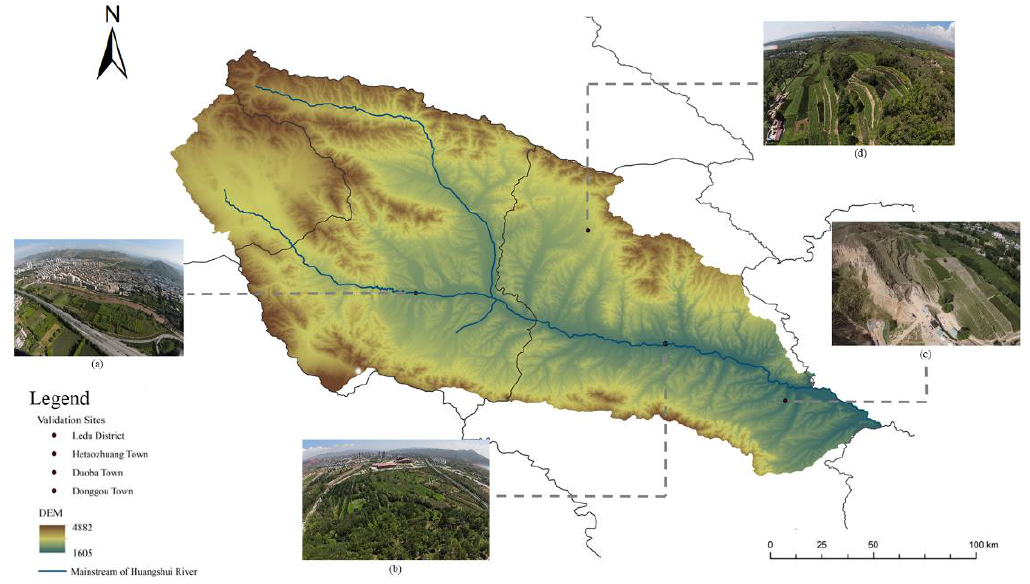
Figure 7. Distribution of validation sites for risk analysis: ( a ) Duoba Town in Huangzhong District; ( b ) urban area of Ledu District; ( c ) Hetaozhuang town in Minhe County; ( d ) Donggou Town in Huzhu County. (WGS84, 1 : 975 000)